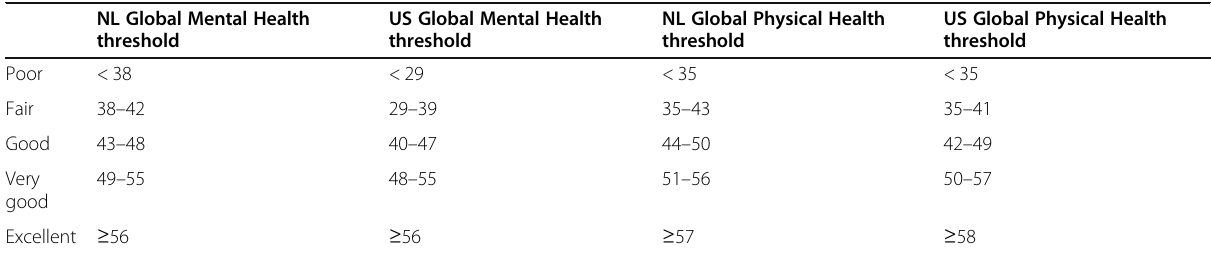
Table 4 Thresholds for GPH and GMH T-scores based on US reference population [25] and the Dutch general